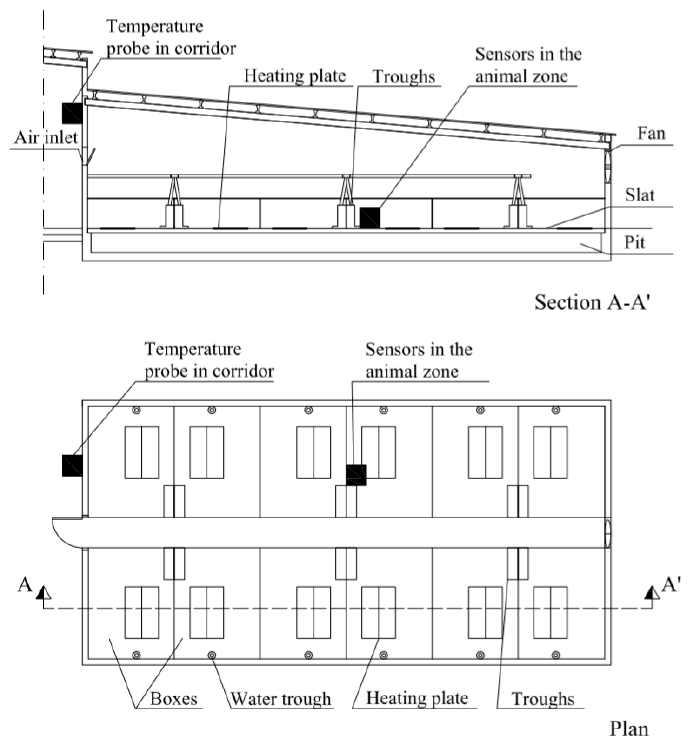
Figure 1. Location of sensors used to measure the study variables.